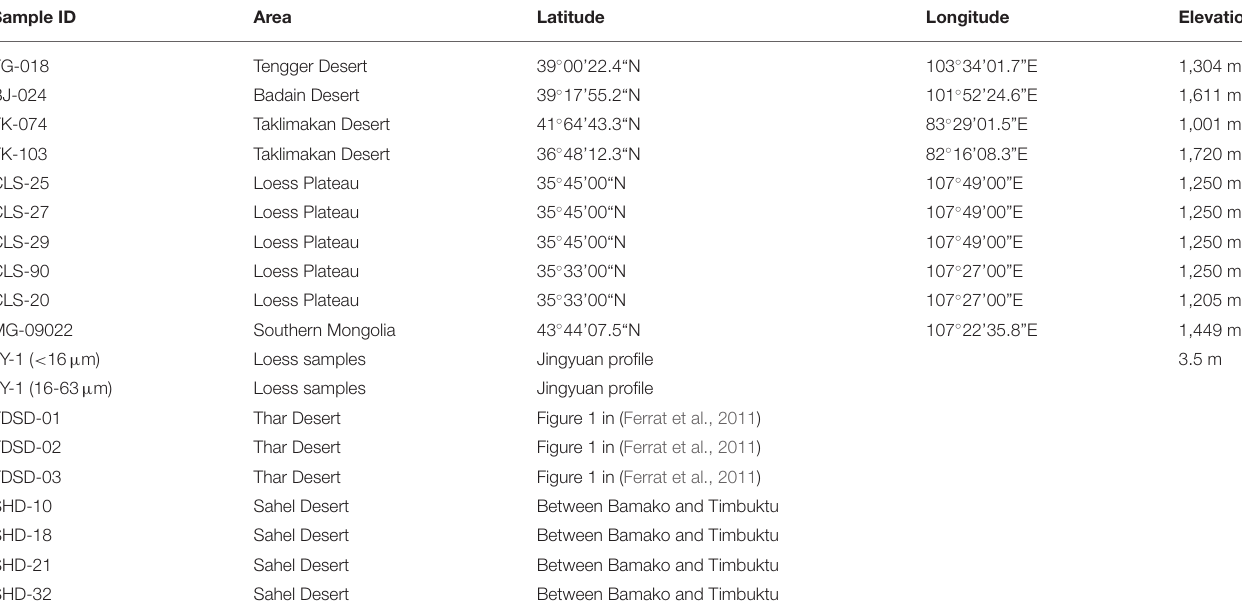
TABLE 1 | Sample ID, area of origin, and information on location of the mineral dust samples. Sample